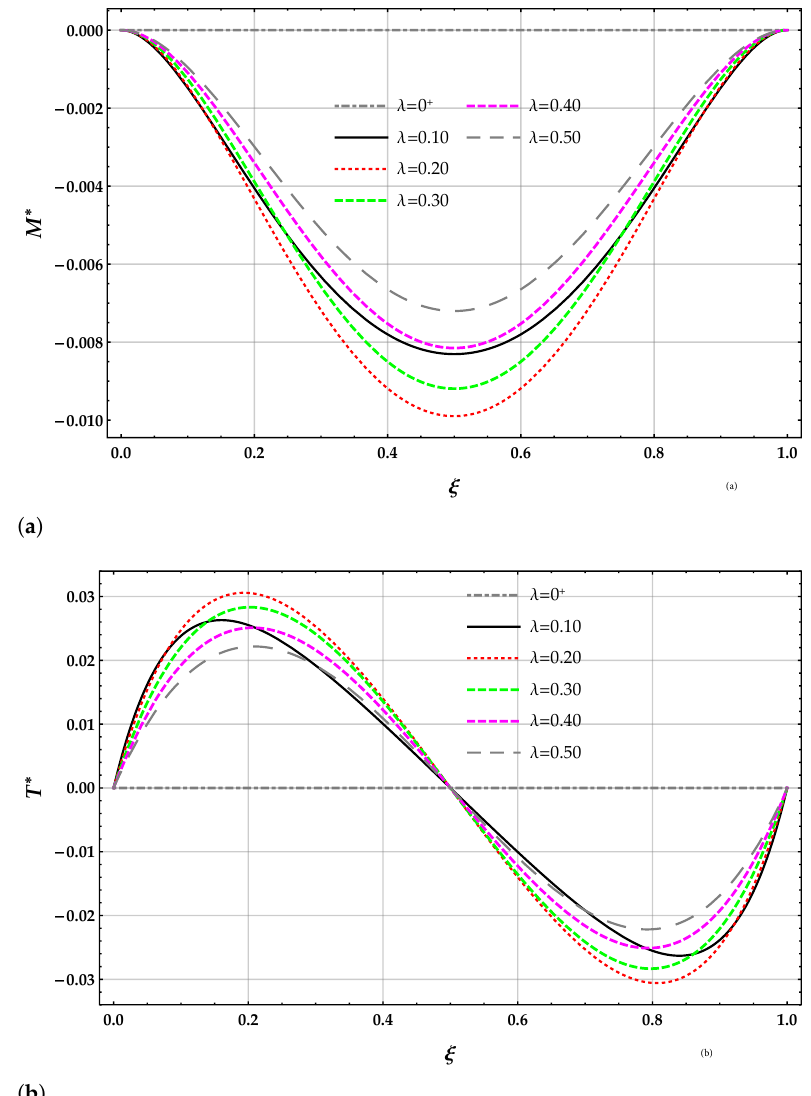
Figure 4. FF − q beam. Plots for increasing values of the non-dimensional non-local parameter λ in (cid:8) (cid:9) the set 0 + ,0.1,0.2,0.3,0.4,0.5 with k ∗ = 10 of ( a ) non-dimensional bending moment M ∗ using the DD method and ( b ) non-dimensional shear force T ∗ using the DD